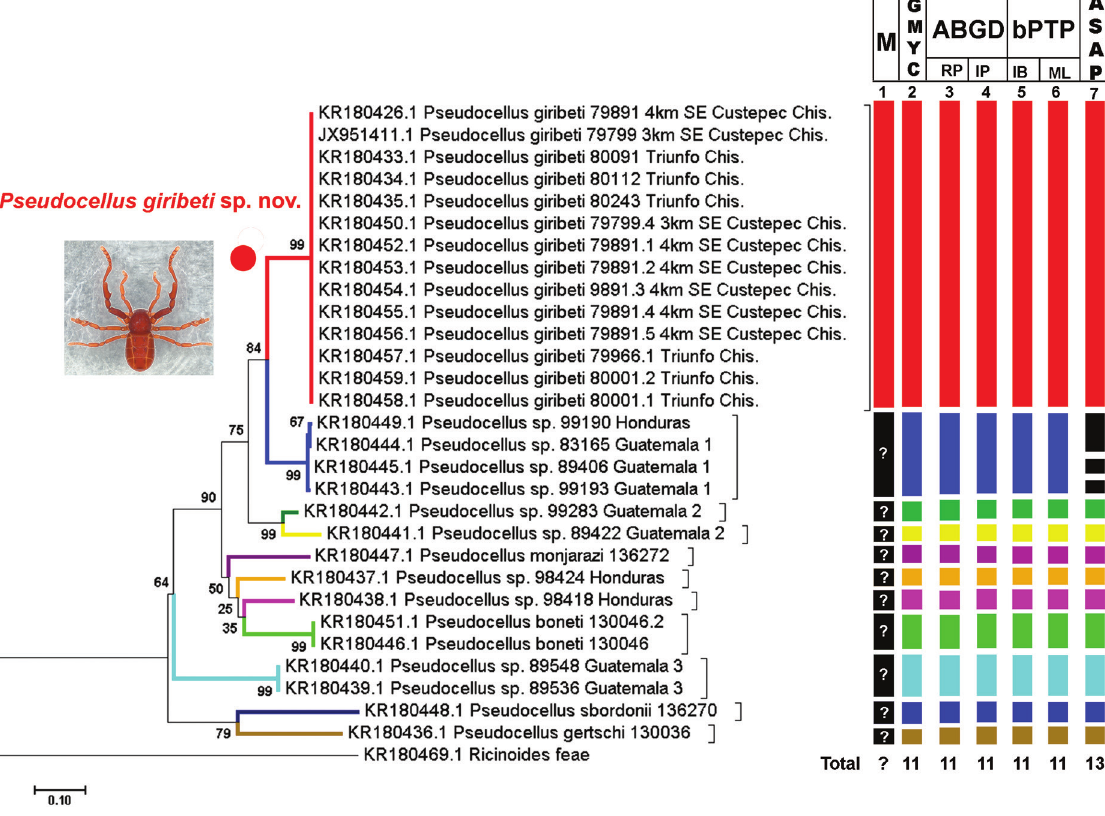
Fig. 2. Maximum Likelihood gene tree (highest log: -3134.13), constructed with COI barcode sequences of Pseudocellus Platnick, 1980 . Colors of the branches indicate species; same colors are in the bars, which represent the different species delimitation methods used for their validation. Red branches + red circle indicate the new species described herein. Numbers below the bars represent the number of species recovered under each species delimitation method (not considering the outgroup: Ricinoides feae (Hansen, 1921)): 1: morphology (M). 2: GMYC. 3: ABGD with recursive partitions (RP). 4: ABGD with initial partitions (IP). 5: bPTP with IB. 6: bPTP with ML. 7: ASAP. Numbers on the branches are Bootstrap support values (>50%